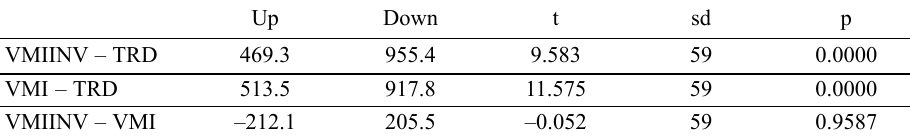
Table 6. Paired comparisons for total system profit